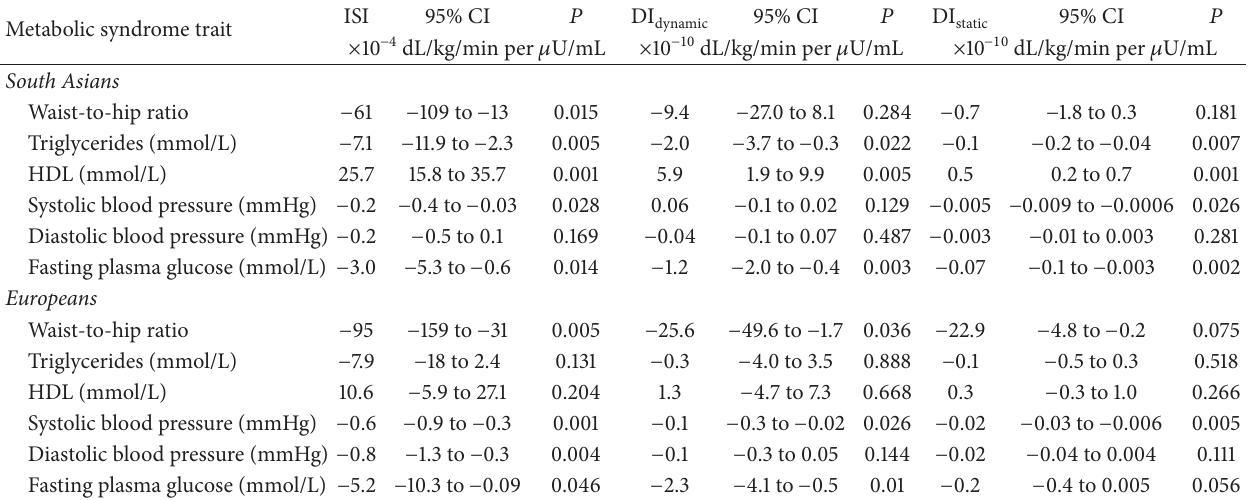
Table 2: Relationship between metabolic syndrome traits and insulin sensitivity index (ISI), dynamic disposition index (DI dynamic ), and static disposition index (DI static ) adjusted for sex and age according to